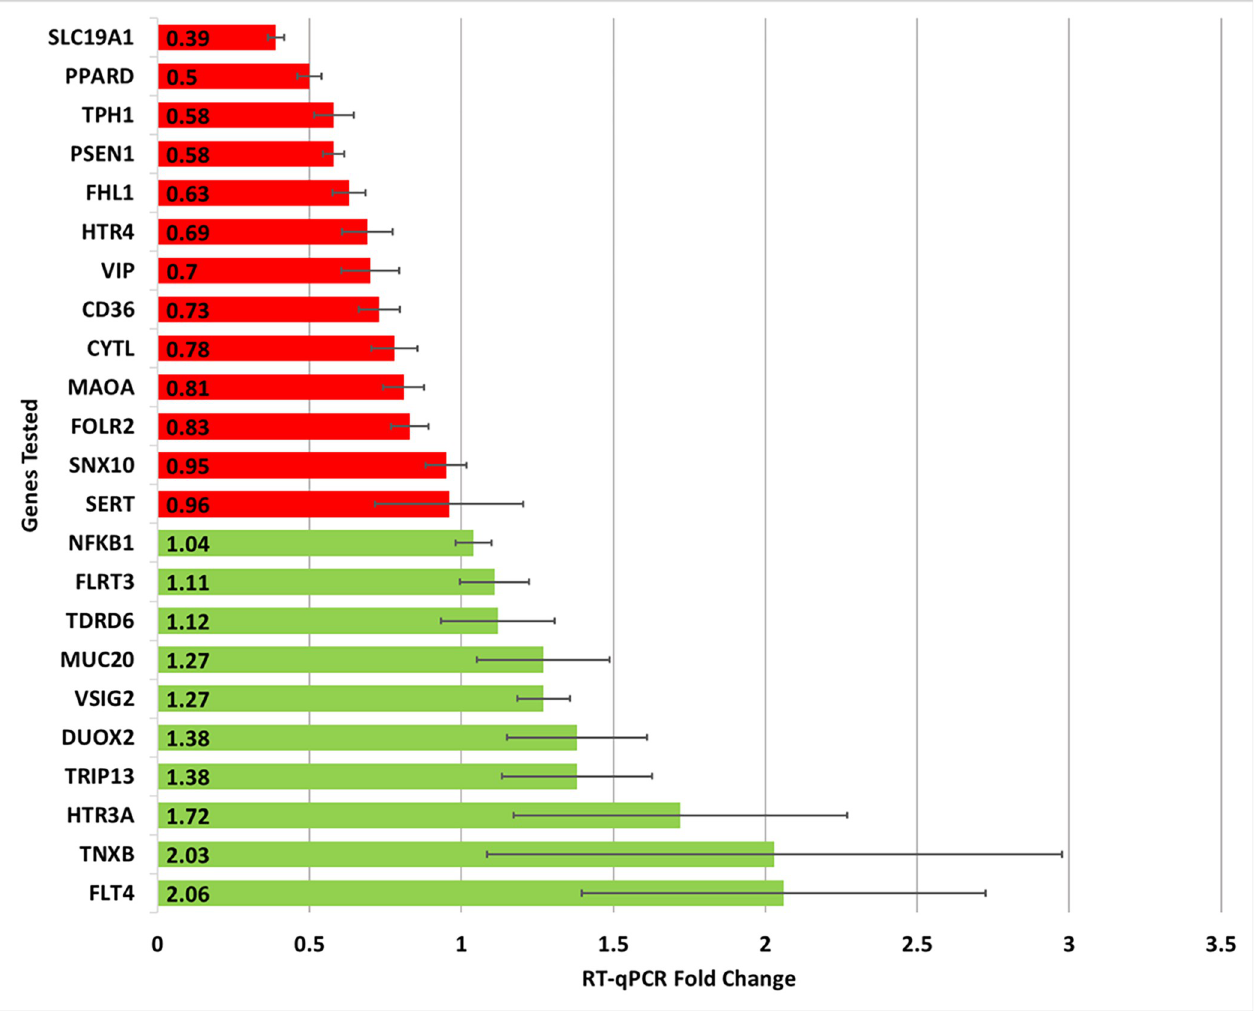
Fig 2. Gene expression fold change in IBS patients relative to control patients using RT-qPCR testing. In total, 29 genes of interest were evaluated with only 23 being reported here (only those genes with at least two independent RT-qPCR plate replicates are included). Red coloration is indicative of lower levels of expression while green represents higher expression levels with SEM being